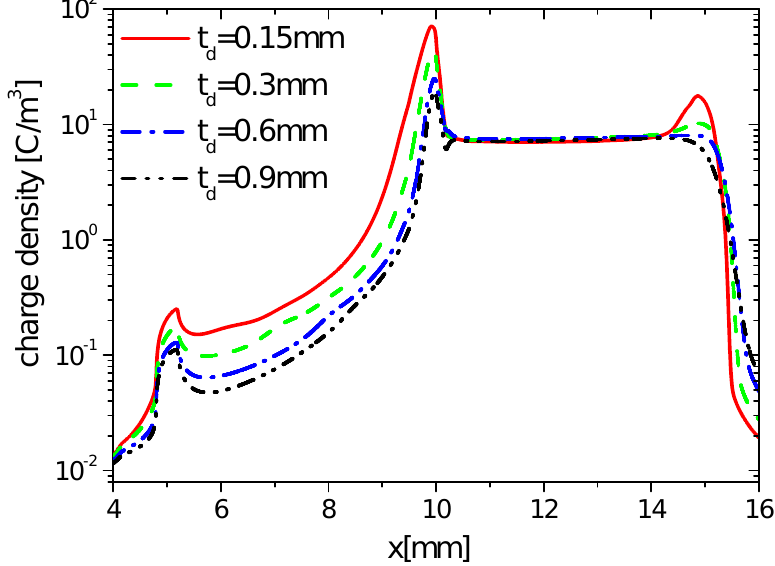
Figure 25. Effect of t d on the distributions of the wall charge density at 35 ns in the fall